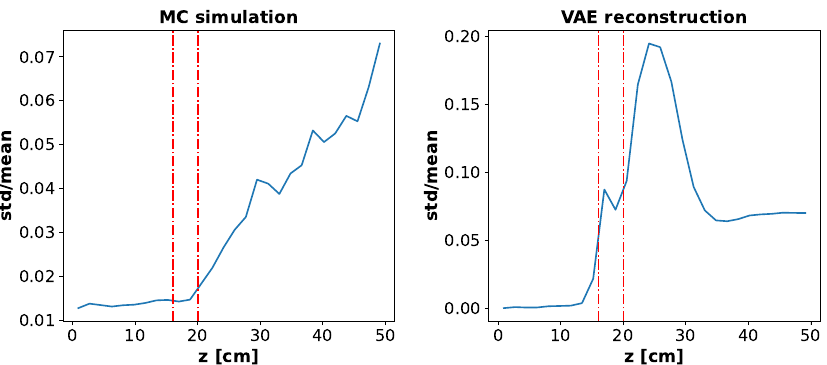
Figure 6. Standard deviations in MC and VAE . Comparison of standard deviation over mean of the energy profile along the z axis between Monte Carlo simulations and VAE reconstruction in the Water + Slab setting. Values are estimated for 100 MC runs with fixed parameters and 100 VAE execution with the same example as input. Results demonstrate how VAE’s largest errors are in regions where energy deposition fluctuation, and so Monte Carlo’s ones, are not